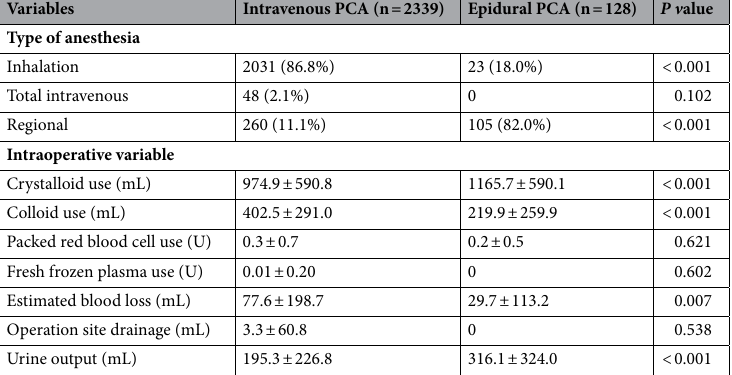
Table 2. Unmatched intraoperative variables between the intravenous PCA and epidural PCA groups. Data are presented as mean ± standard deviation or number (%), as appropriate. PCA patient-controlled analgesia.